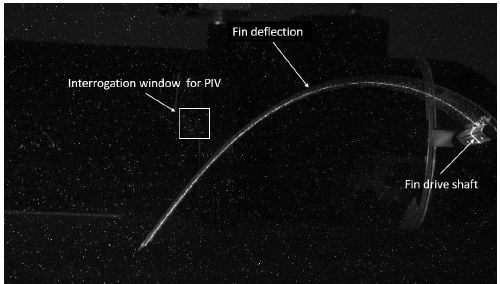
Figure 4. The example of input data for analysis with highlight markers and illuminated the fin deflection.